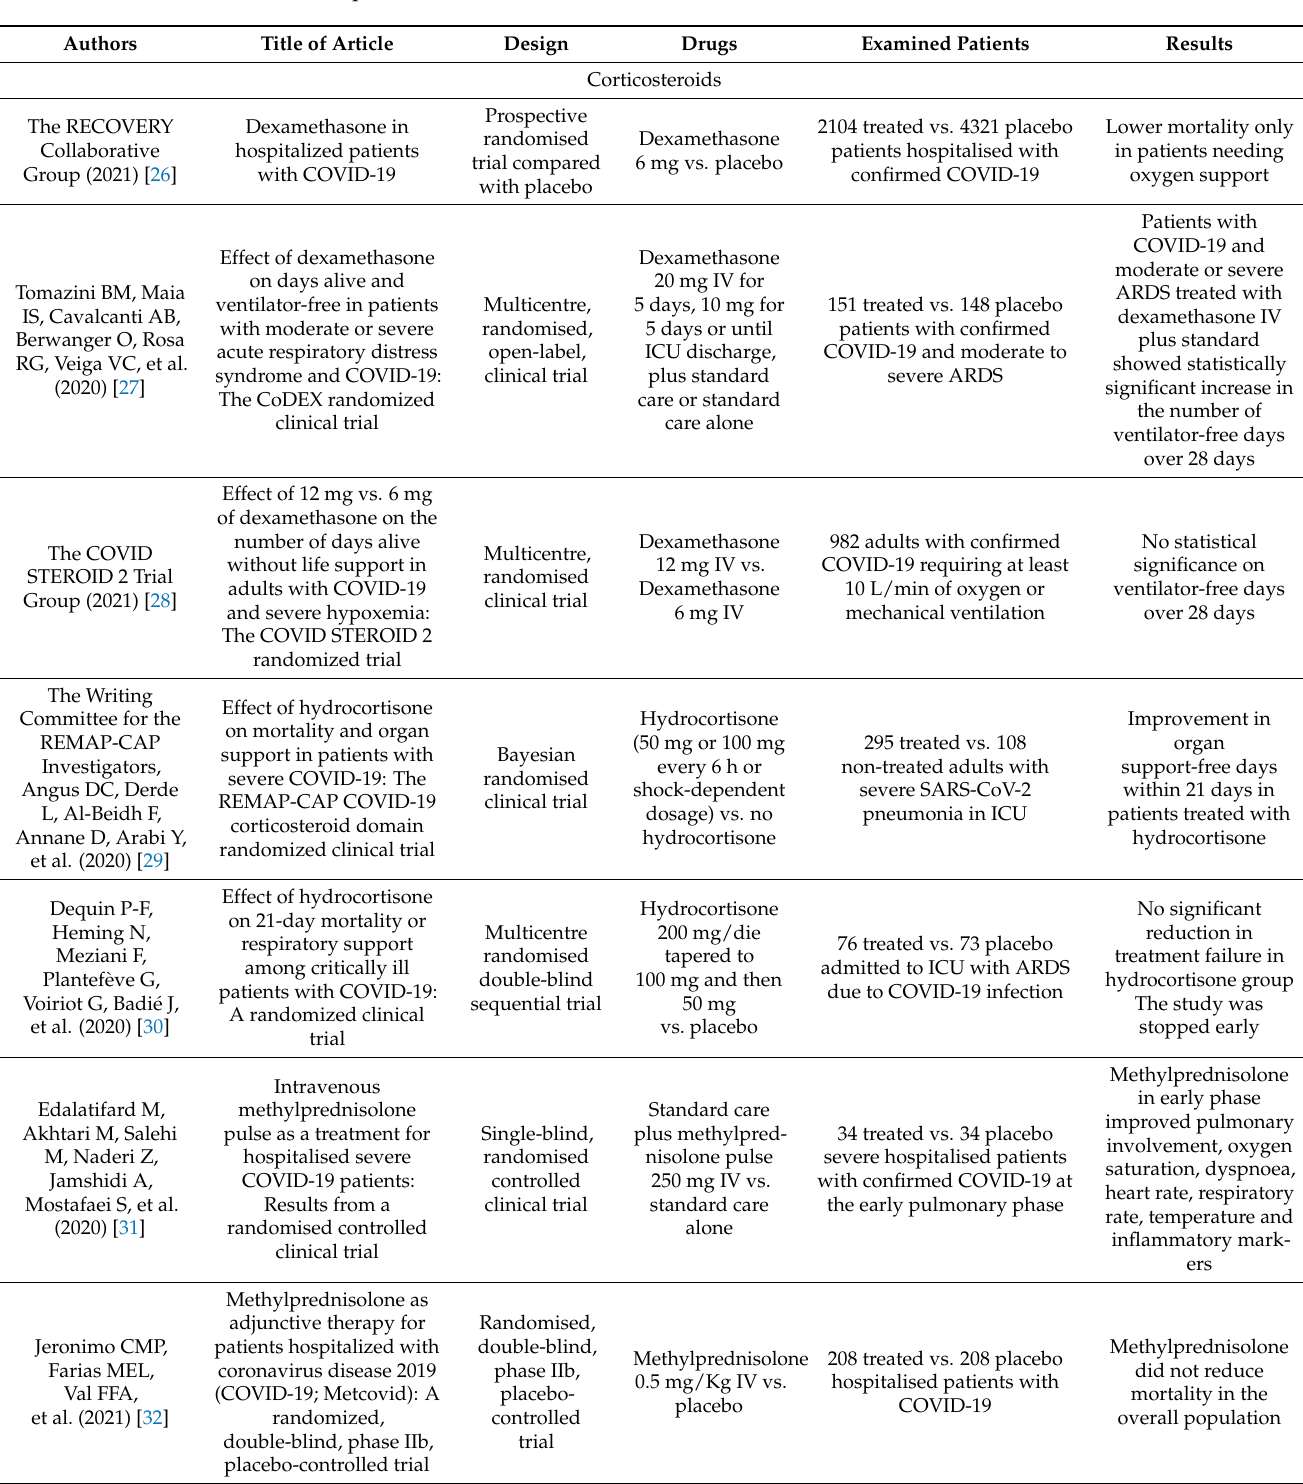
Table 1. Table of studies investigating different types of host-based treatment in different sub-groups of patients with SARS-CoV-2